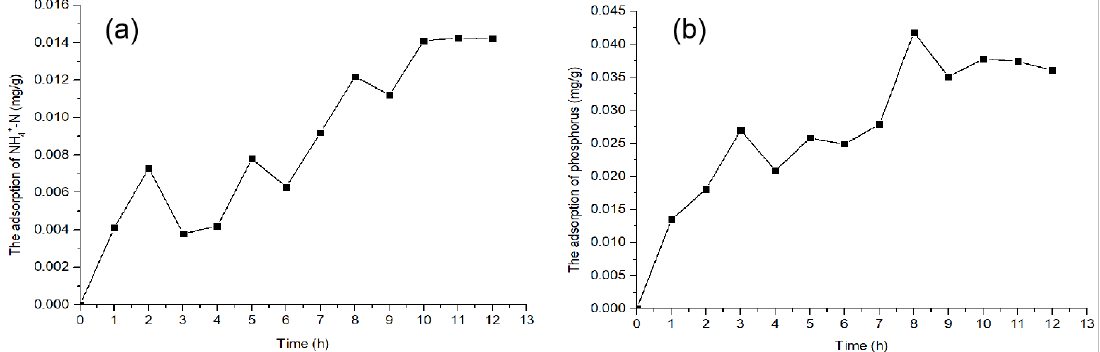
Figure 4. The effects of matrix adsorption on NH 4+ -N and phosphorus adsorption, ( a ) NH 4+ -N Figure 4. The e ff ects of matrix adsorption on NH 4 + -N and phosphorus adsorption, ( a ) NH 4 + -N adsorption by matrix ( b ) Phosphorus adsorption by matrix. adsorption by matrix ( b ) Phosphorus adsorption by